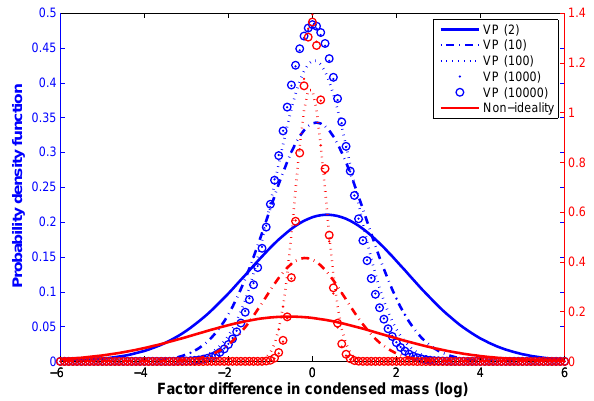
Fig. 4. Sensitivities of predicted total organic mass for an example functionality distribution across changing temperatures for wet (green bars, n =9) and dry (blue symbols, n =3) conditions using the partitioning model with each of the vapour pressure predictive techniques.